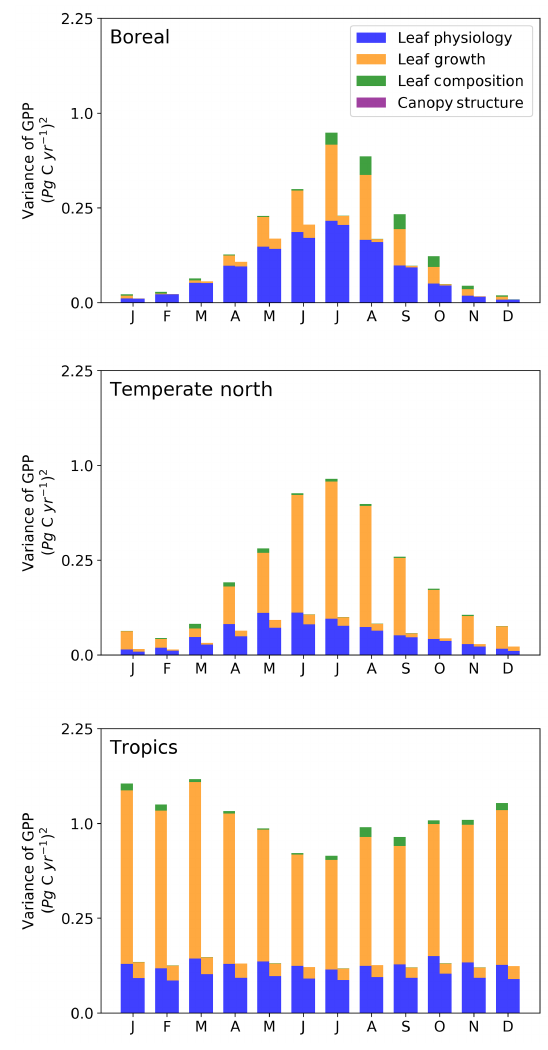
Figure 7. Contribution of parameter classes to parametric uncer- tainty in monthly GPP for three regions (see Table A1 for details on these parameter classes). For each month, the bar on the left is the prior and the bar on the right is the posterior. Uncertainties are represented as variances; thus, the units are in PgCyr − 1 squared, and, for clarity, the y axes are on a quadratic-transformed